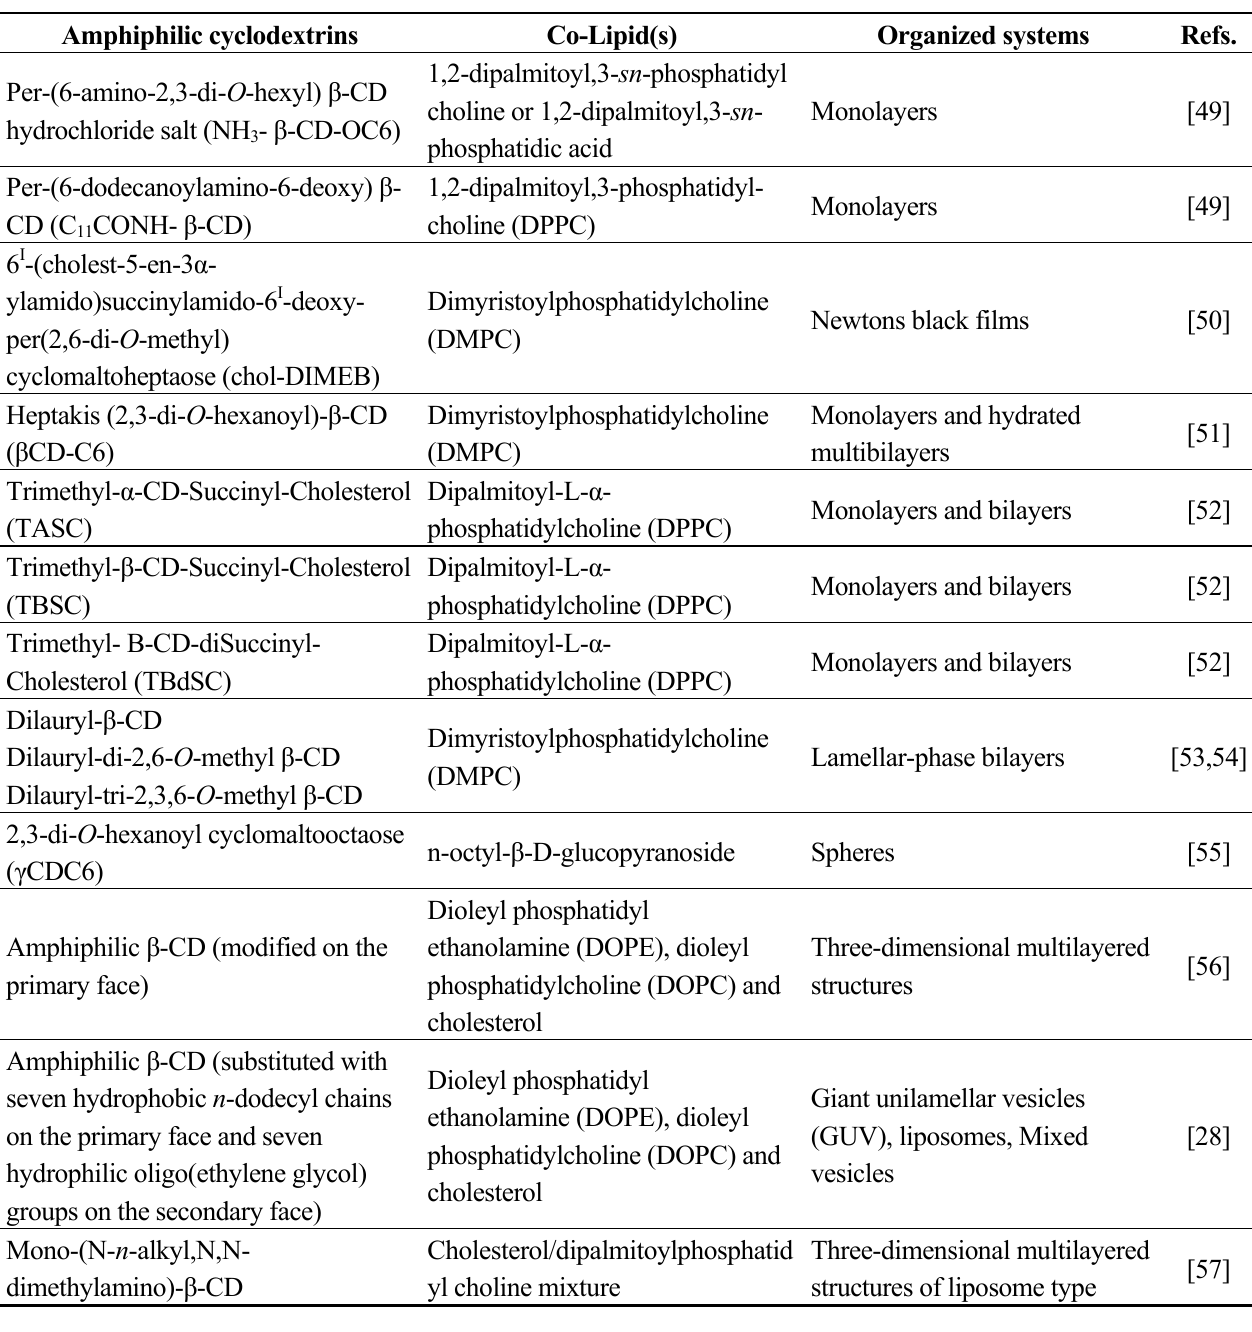
Table 2. Mixed systems formed by amphiphilic cyclodextrins and